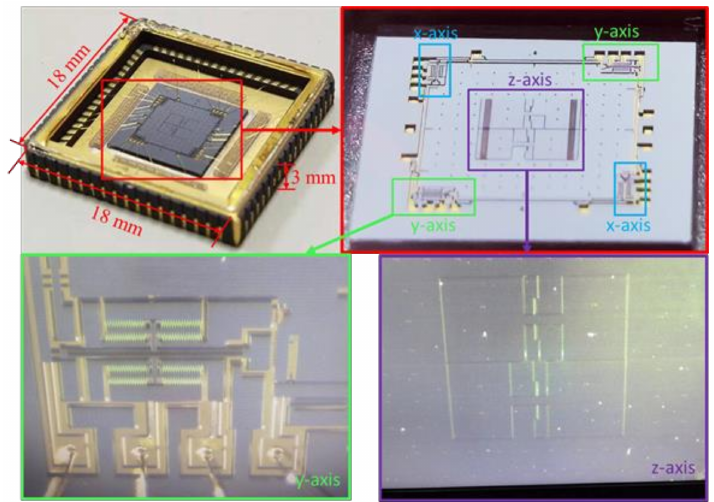
Figure 5. MEMS packaging and internal